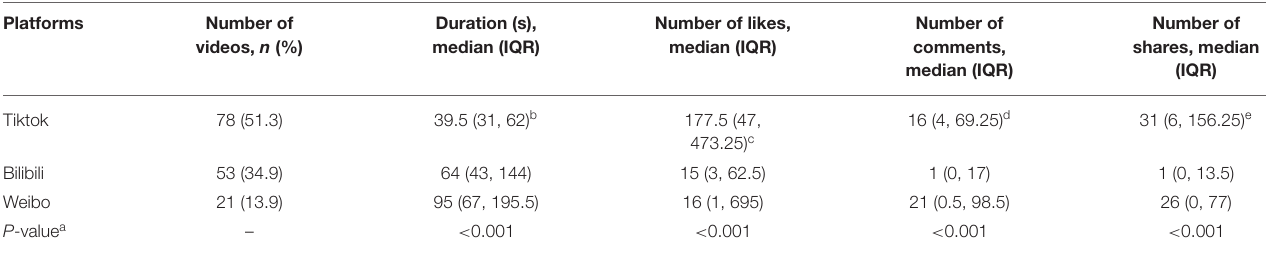
TABLE 5 | General features of included videos in different social media platforms.